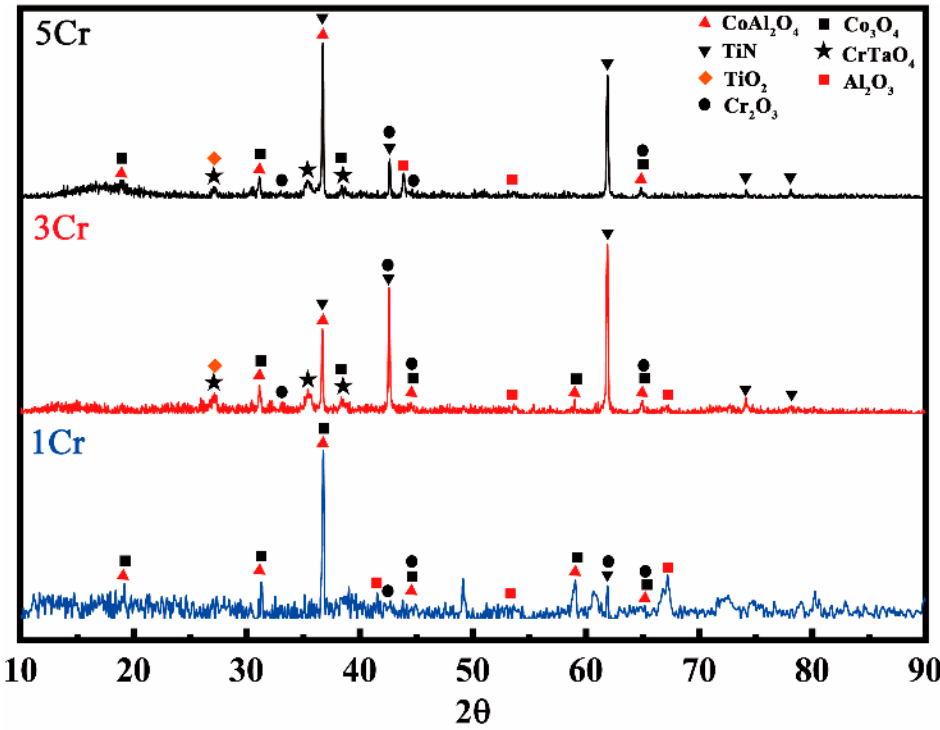
Figure 4. X-ray diffraction patterns of surface indexed to the oxide phases grown after oxidizing for 100 h at 900 °C.